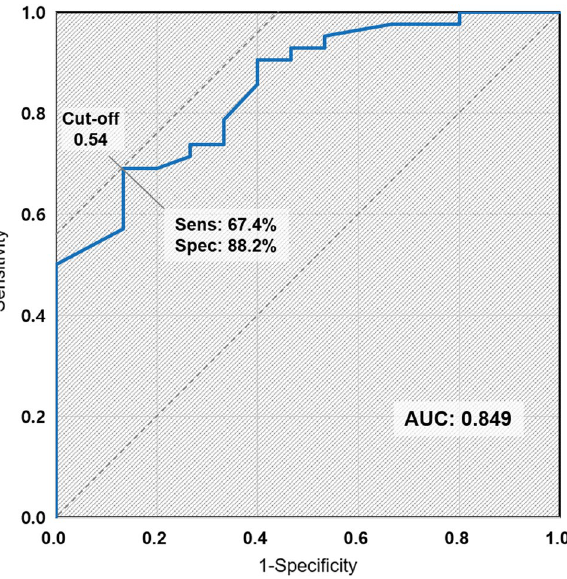
Figure 2. ROC curve analysis for endotoxtin activity level with measured areas under curve (AUC) of 0.849. ROC receiver operating